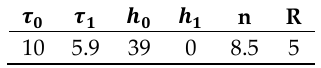
Figure 9. Experimental and simulated stress strain curves at different strain rates under compression. Table 4. Voce hardening